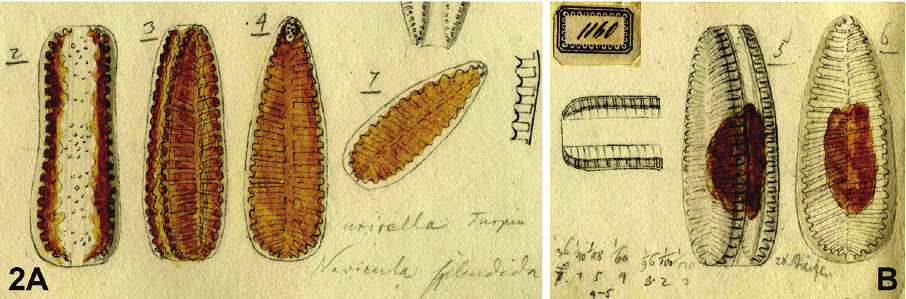
Figure 2. Iconella splendida . Lectotype: Drawing BHUPM 1160. A The alive cell representing the lec- totype in three views (hand written numbers 2-4), length 188 µm B Later documentation of valve details by Ehrenberg, hand written numbers 5-6 represent a 226 µm long